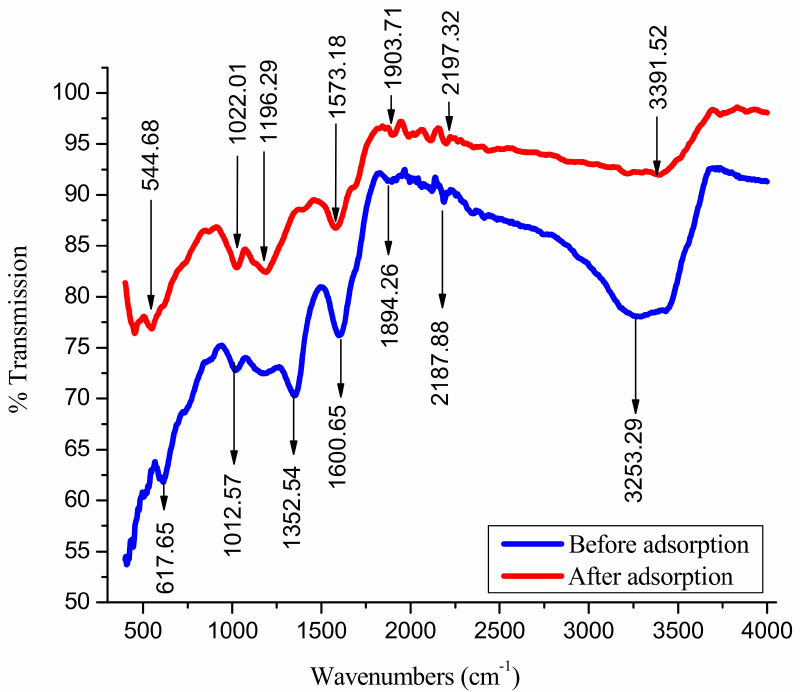
Figure 2. Fourier Transform Infrared Spectroscopy (FT-IR) spectrum of walnut shell biomass activated carbon adsorbent before and after RBBR dye